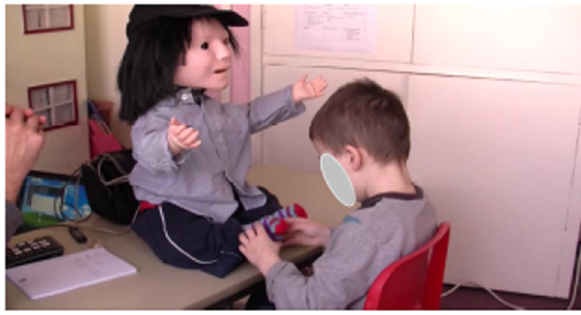
Figure 4: A child with autism ’ s tactile exploration of